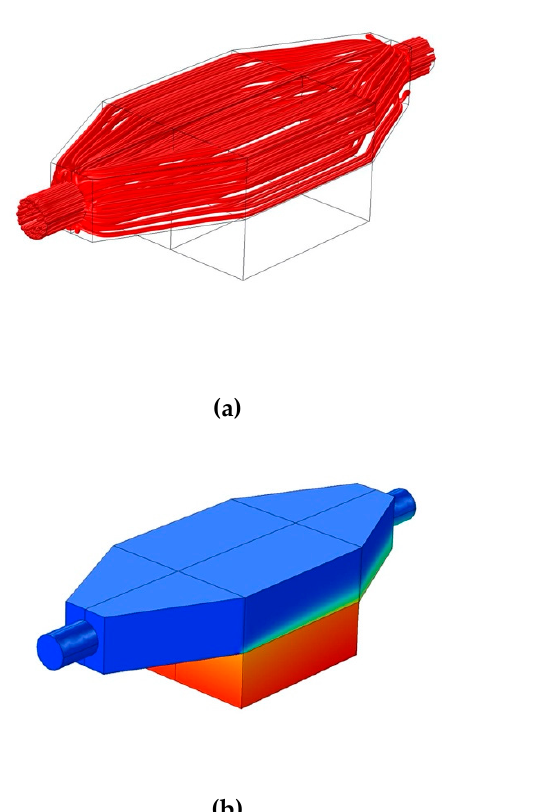
Figure 7. Heat transfer and fluid flow displacement in the model. ( a ) Flow along the model, ( b ) Temperature distribution in the model.